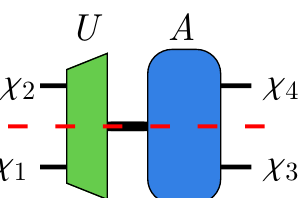
χ ) × χ × χ ≤ χ , where χ 1 2 3 4 1 3 (green) that roughly mini- ij , k